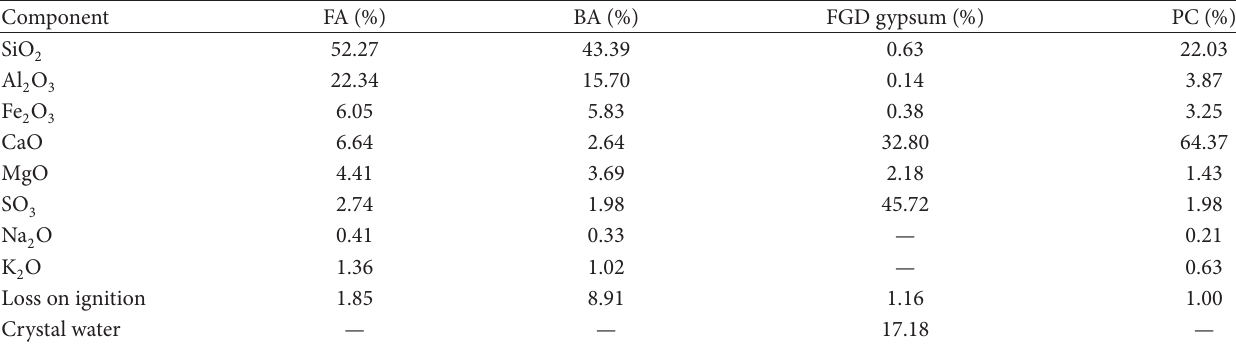
T 1: Chemical compositions of the materials.